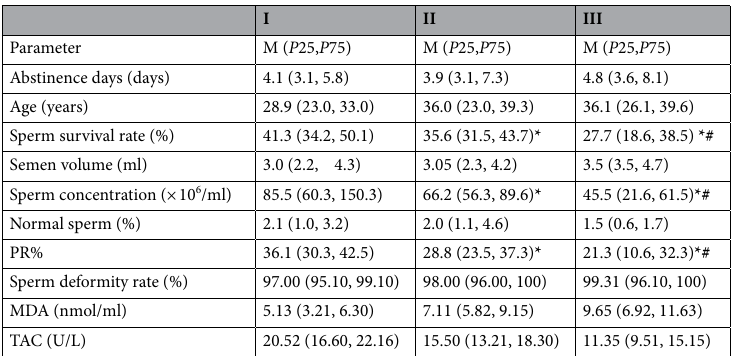
Table 1. Comparison of semen parameters between different sperm DFI levels. All data in the table are represented by M (P25, P75). * Compared with group I, # compared with group II, P < 0.01. According to DFI levels, there were 468 cases in group I (DFI ≤ 15%), 518 cases in group II (15% < DFI < 30%), and 476 cases in group III (DFI ≥